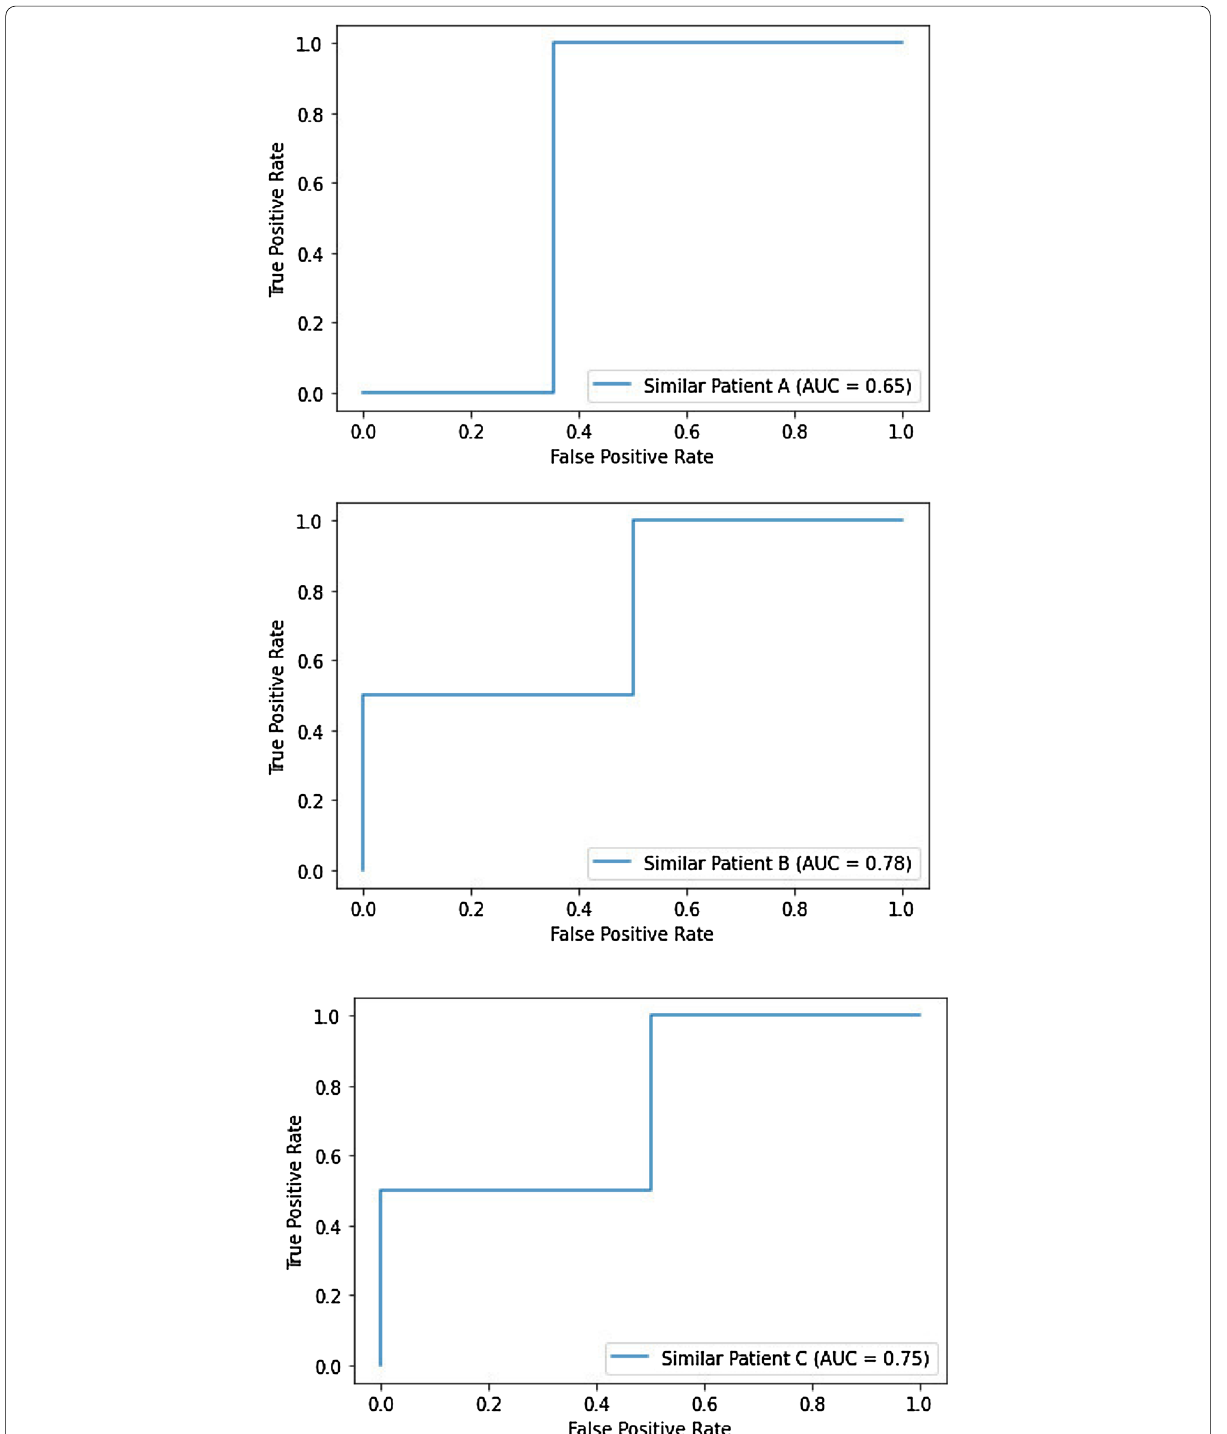
Fig. 3 ROC curve for domain